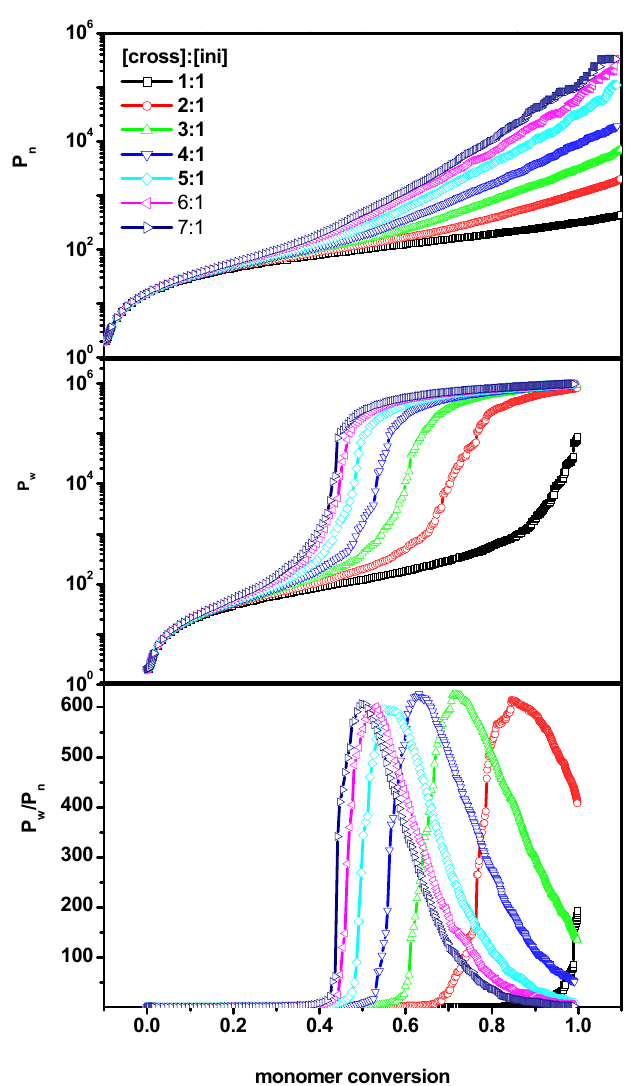
Figure 1. The number-average chain length ( P n ) ( upper ), the weight-average ( P w ) ( middle ) and the dispersity ( P w / P n ) ( lower ) vs. monomer conversion for the initiator concentration 0.6%. The case of a free solution (system A). The values of the ratios [Ini]/[X] are given in the inset to the upper Figure. The above behavior of P n , the weight-average P w and P w / P n could now be compared with the results obtained when the polymerized system was subjected to geometric con- straints, i.e., with system B, where the chains were inserted into a slit built of parallel walls with a spacing of d = 100 and 10 lattice units. In the situations considered, the ratio